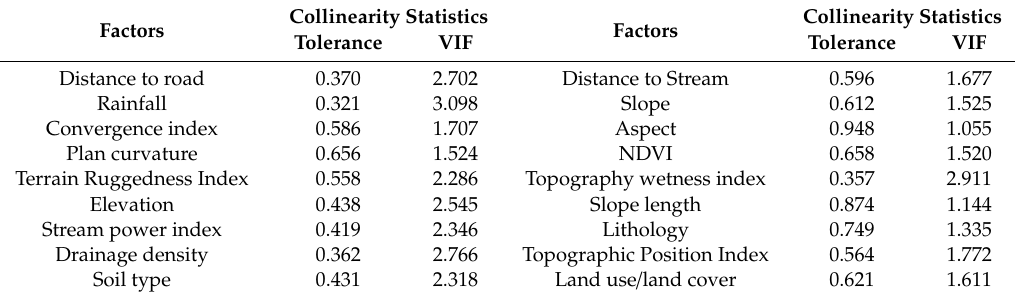
Table 3. Multicollinearity Analysis of Gully Erosion Conditioning